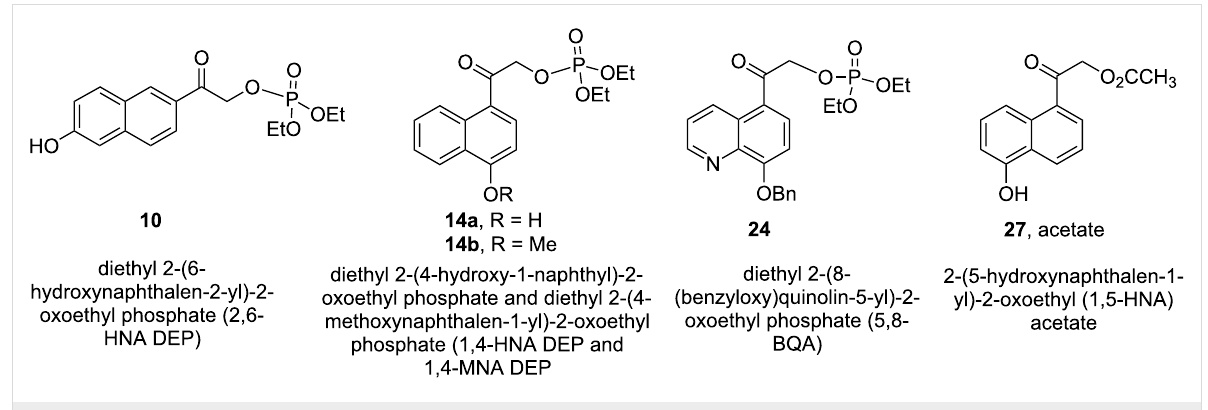
phenacyl ( 4a ) analogs (see Table 4, Discussion section). A complex product mixture of byproducts of the